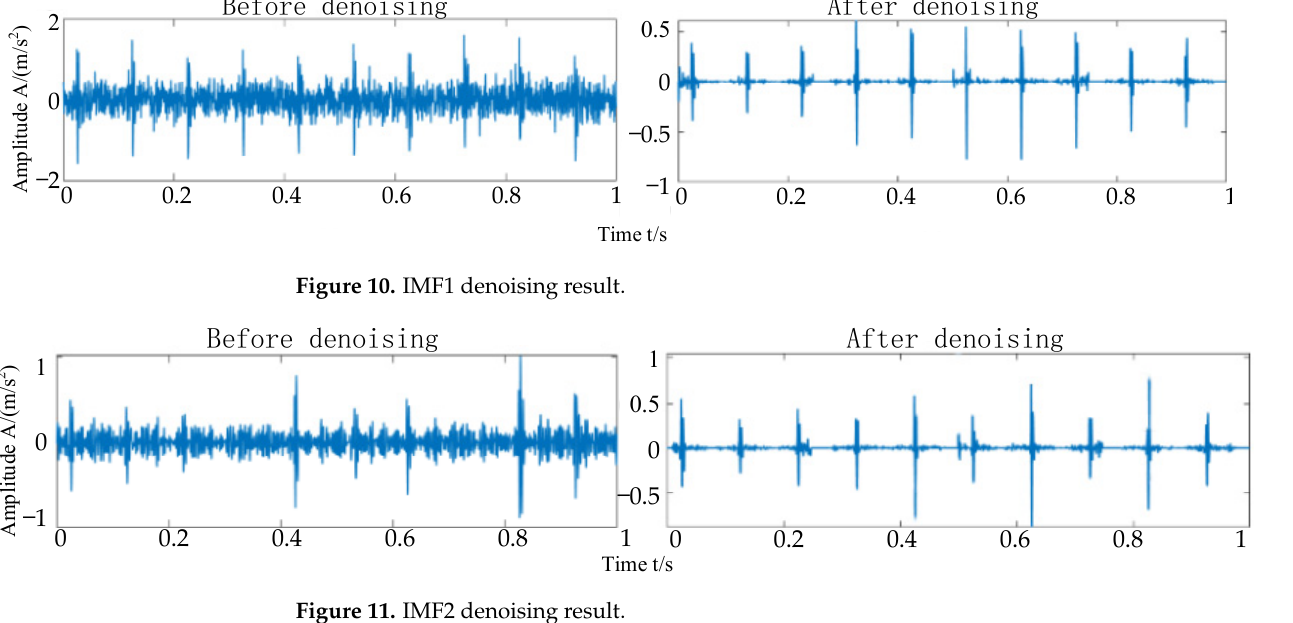
Figure 11. IMF2 denoising result.